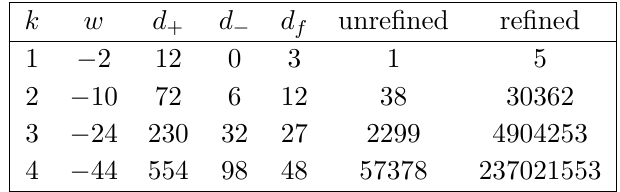
a 2 in terms of D ( b 2 )